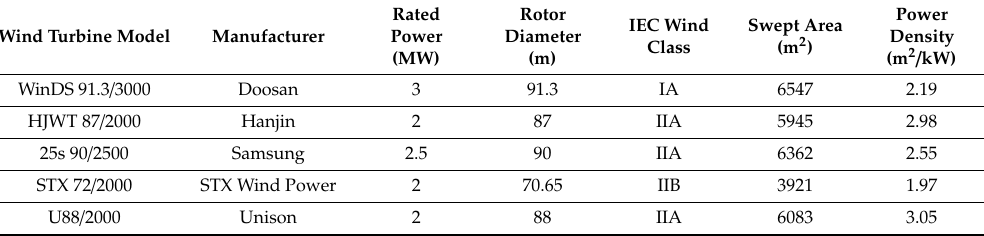
Table 5. Characteristics of selected wind